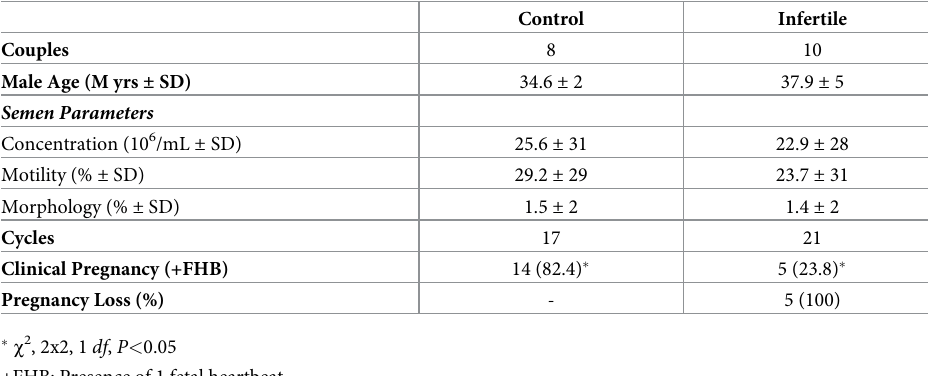
Table 1. Couples’ demographic, gamete characteristics and ICSI